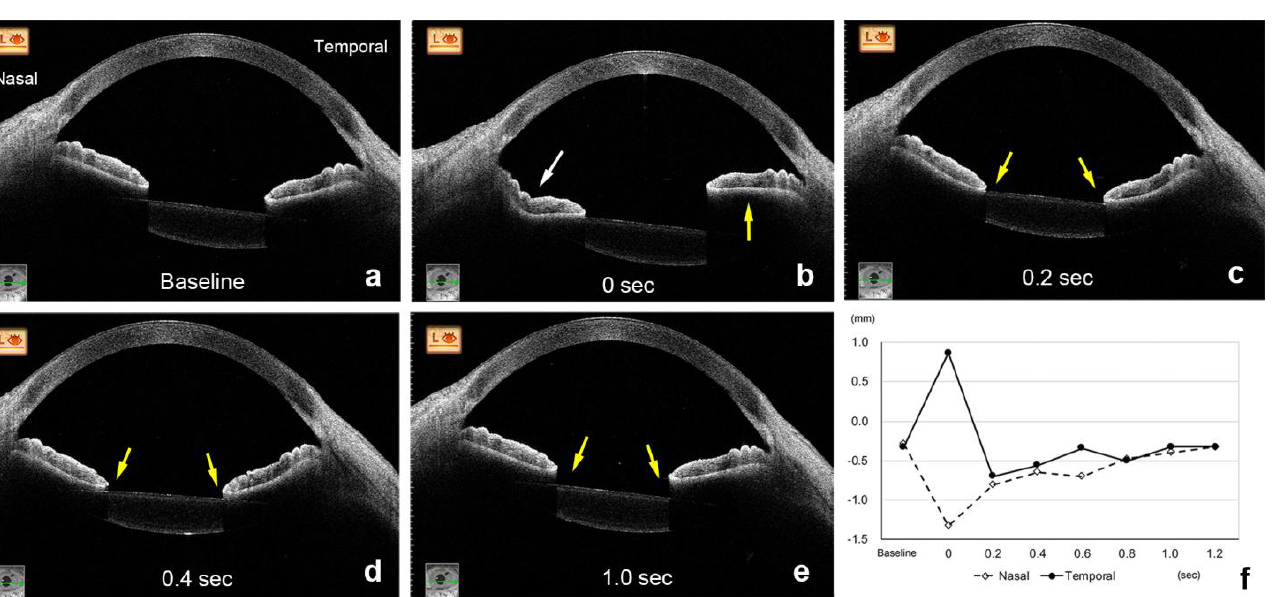
Figure 2. A plot of changes in the height of the temporal and nasal sectors of the iris immediately after a movement of the eye from a 30° temporal position to the primary position in an eye with an intrascleral fixation (ISF) of an intraocular lens (IOL). Also plotted are the values of an eye in which the IOL was implanted in the lens capsule, the control group. ( a ). The height of the nasal sector of the iris of eyes in the ISF group decreases significantly from the baseline at 0 s ( p < 0.001) and returns at 0.2 s. The height of the temporal sector in eyes of the ISF group increases significantly from the baseline at 0 s and returns to the baseline at 0.2 s. ( b ). The height of the nasal sector of the iris in the ISF group at 0 s was significantly smaller than that of the control group ( p < 0.001). The temporal height of the ISF group at 0 s was greater than that of the control ( p < 0.001). The nasal height of the ISF group at 0 s was smaller than that of the control ( p < 0.001). (* p < 0.01).